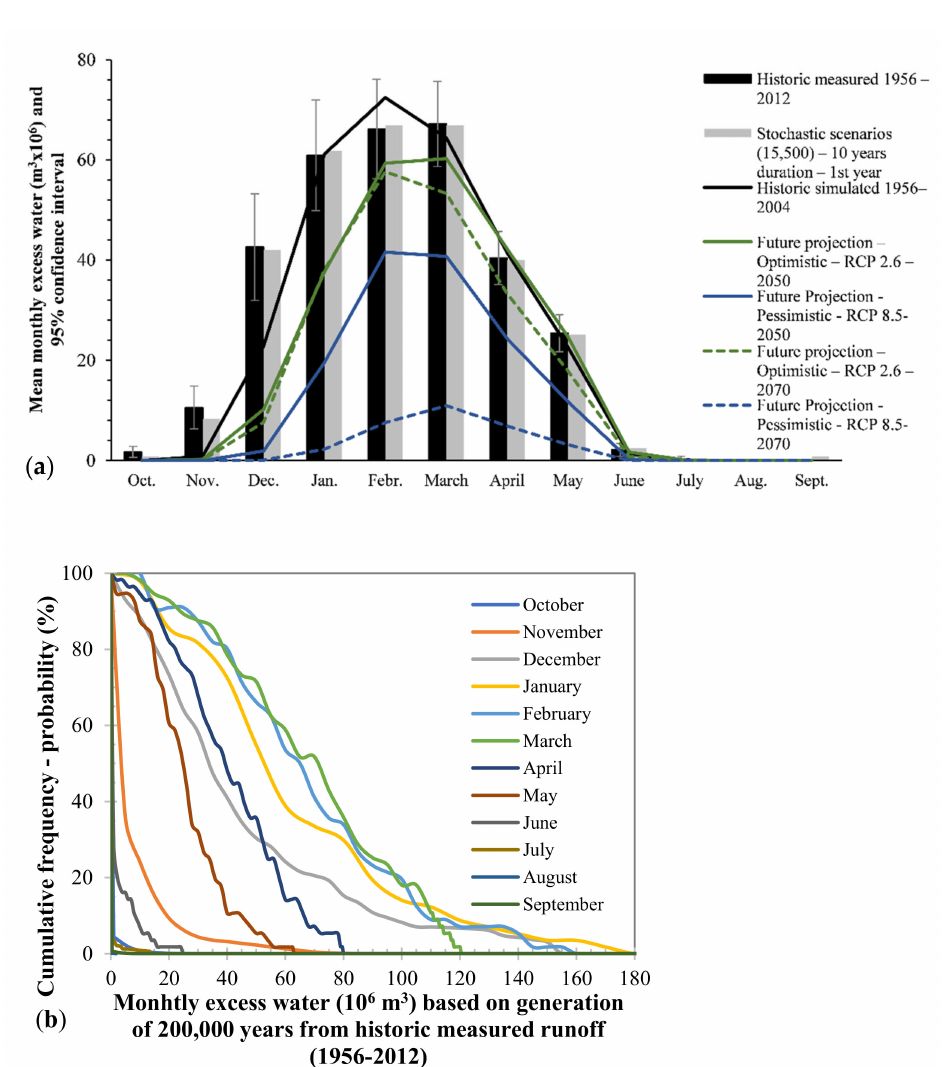
Figure 5. ( a ) Mean monthly excess water ( × 10 6 m 3 ) and 95% confidence interval expressed as: (i) bars for the historic measured (1956–2012) hydrologic data and all stochastic simulations using Castalia and (ii) lines for the simulated hydrologic time series using the ZYGOS hydrologic model based on the historic situation (1956–2004) and the future projections of IPCC climate change scenarios. ( b ) Cumulative frequency—the probability of the monthly excess water (on 10 6 m 3 ) based on the generation of 200,000 years from the historic measured runoff